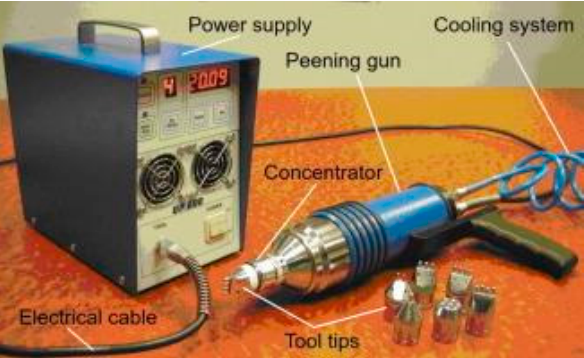
Figure 5. Ultrasonic peening equipment. Reproduced with permission from [80]. Copyright Else- vier, 2015.